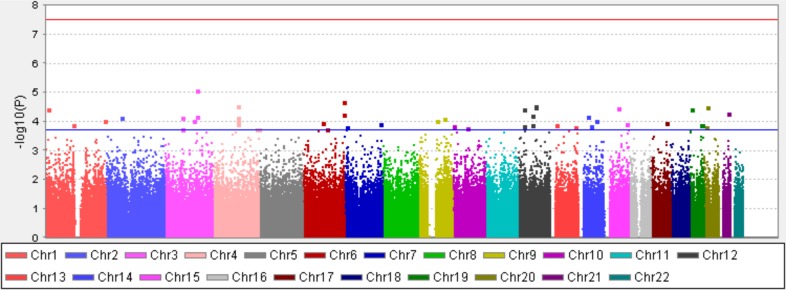
Manhattan plot of the GWAS.Manhattan plot showing the -log10-transformed P value of SNPs in the GWAS for Ki-67 response in 275 patients with breast cancer receiving preoperative tamoxifen monotherapy. The red line indicates the significance level in the GWAS (P < 3.21 x 10−8). The blue line indicates the threshold for P = 2.03 x 10−4 (Top 100 signals).